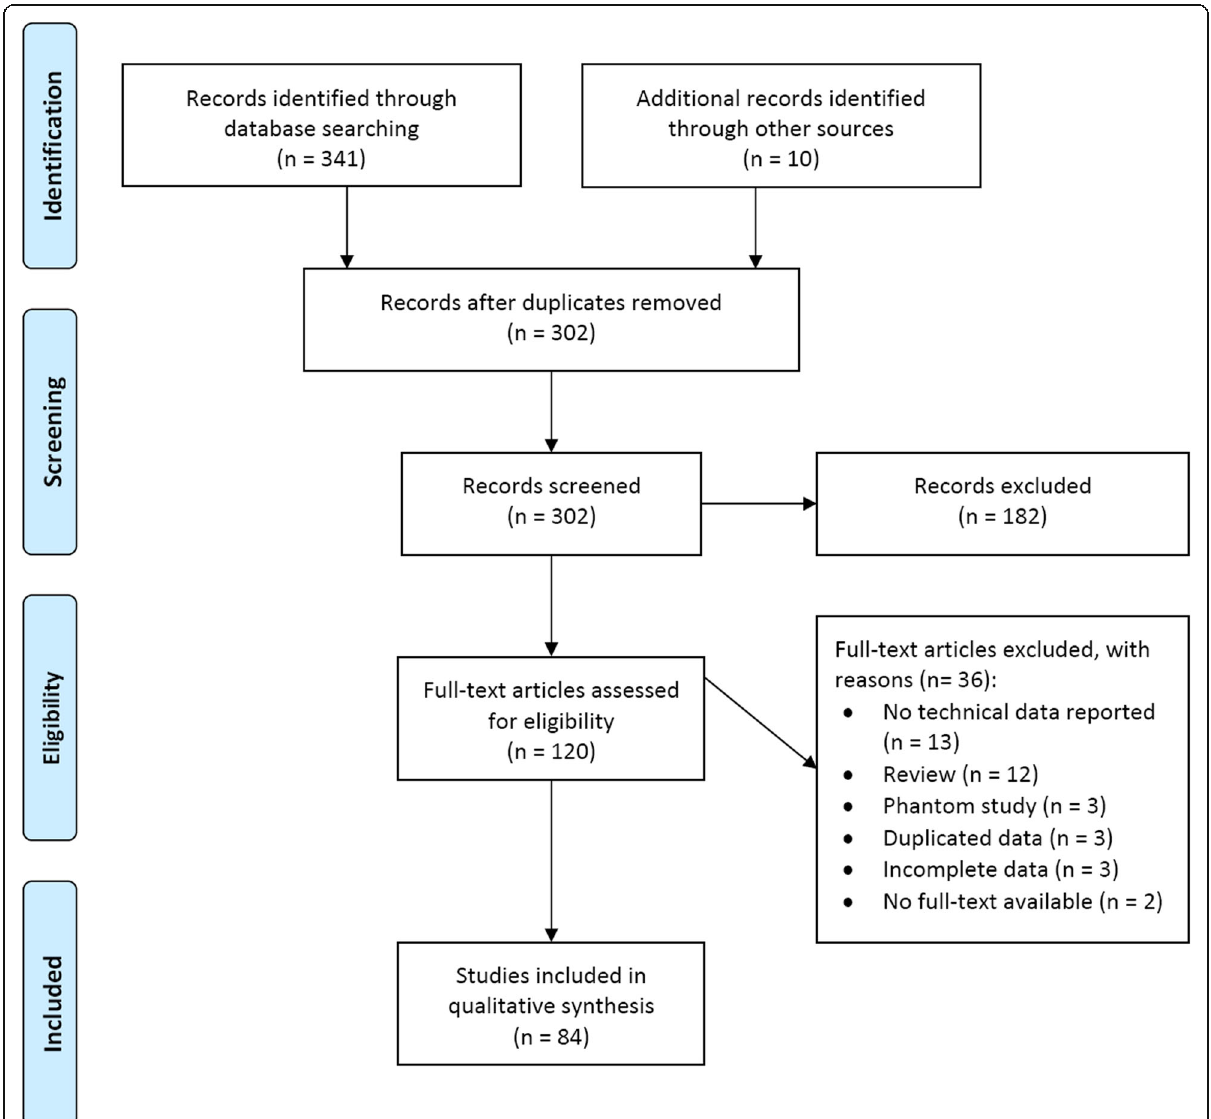
Fig. 1 Flowchart of the study selection and exclusion for articles on contrast-enhanced spectral